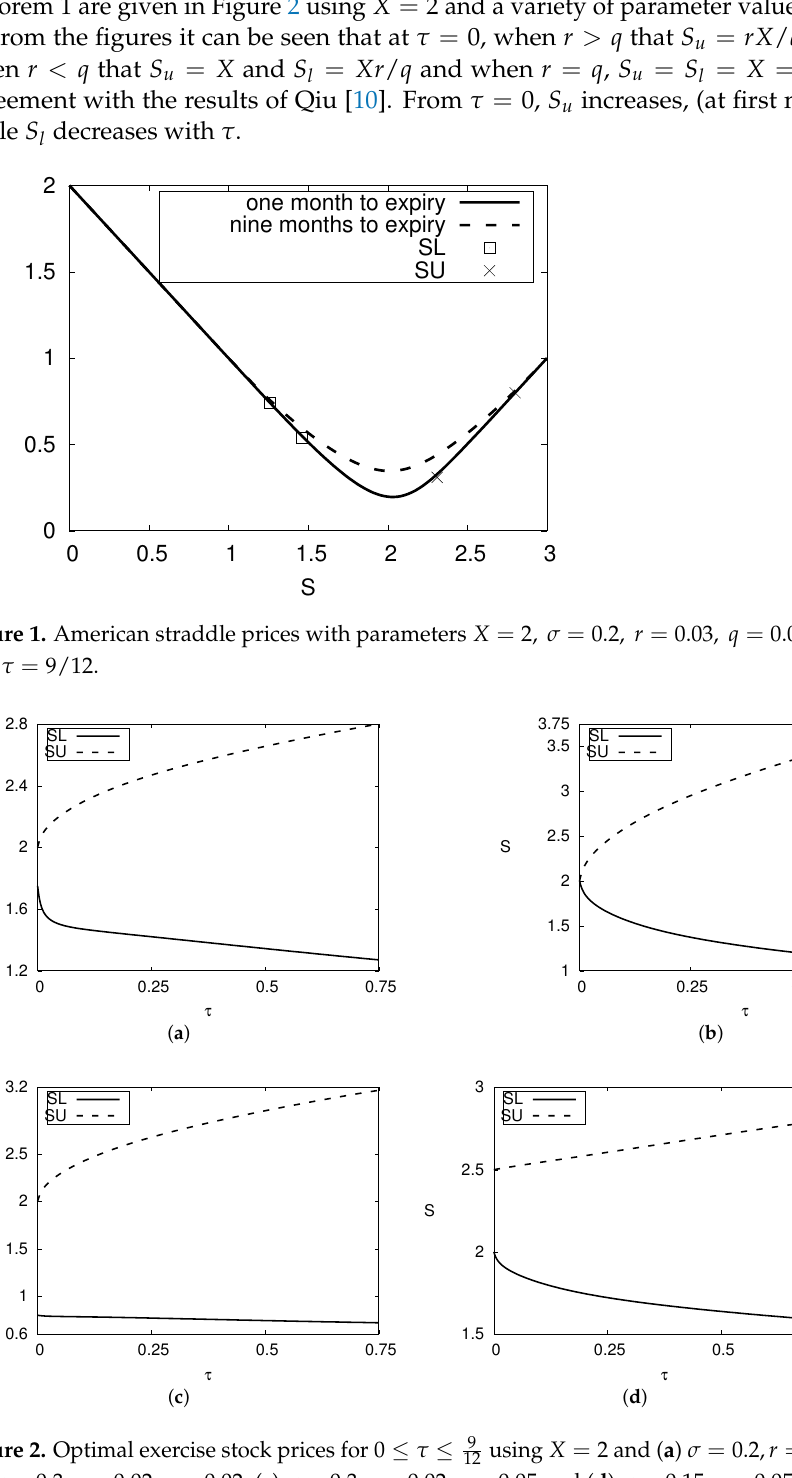
using X = 2 and ( a ) σ = 0.2, r = 0.03, q = 0.04, 12